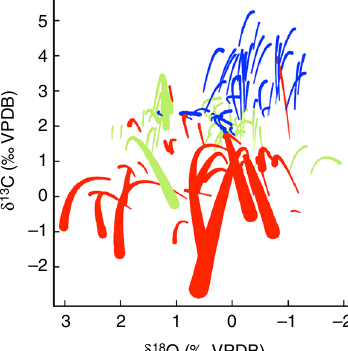
Fig. 3 Synthetic predictions of species δ 13 C and δ 18 O size trends. Model- averaged predictions are made for each of the species in our data set, assuming a common oceanographic setting (i.e., subtropical Atlantic Ocean sediment sample at 1500 m water depth). Lines are colored for visualization purposes only as follows: Quaternary-Neogene – Oligocene (red), Paleocene – Eocene (blue), and Cretaceous (green). Predictions are only made across the range of body sizes available for each species in the original data set (which is capped at 1150 µ m in this projection) and the line thickness is directly proportional to the species body